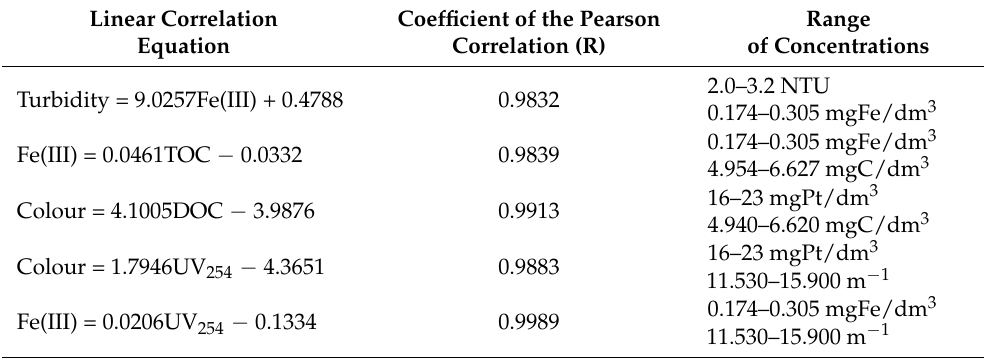
Table 1. Relationship between the iron, colour, turbidity and the organic matter indices of the water samples after PAXXL1911coagulation. Linear Correlation Coefficient of the Pearson Range Equation Correlation (R) of Concentrations 2.0–3.2 NTU Turbidity = 9.0257Fe(III) + 0.4788 0.9832 0.174–0.305 mgFe/dm 3 0.174–0.305 mgFe/dm 3 Fe(III) = 0.0461TOC − 0.0332 0.9839 Colour = 4.1005DOC − 3.9876